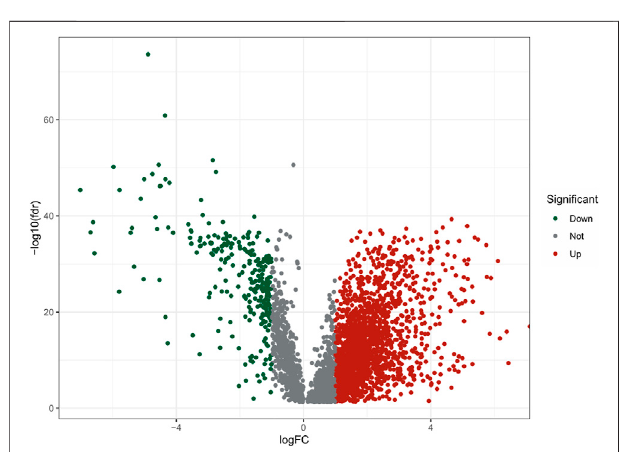
FIGURE 2 | The volcano plot of 2121 differentially expressed m7G- realted